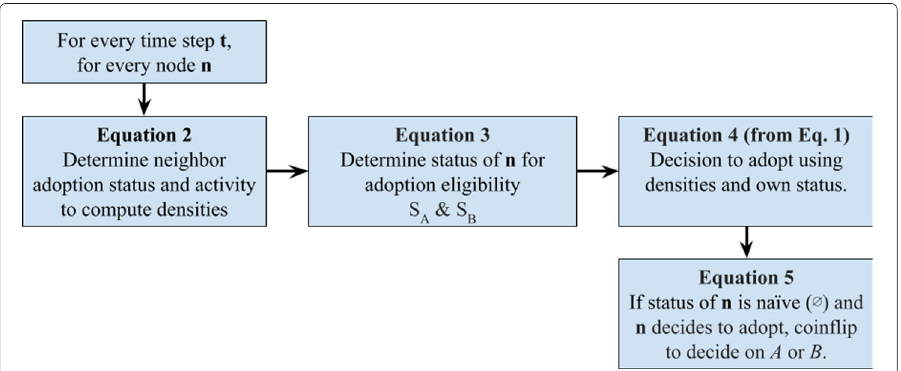
Fig. 2 Algorithmic flowchart of simulating the co-contagion diffusion